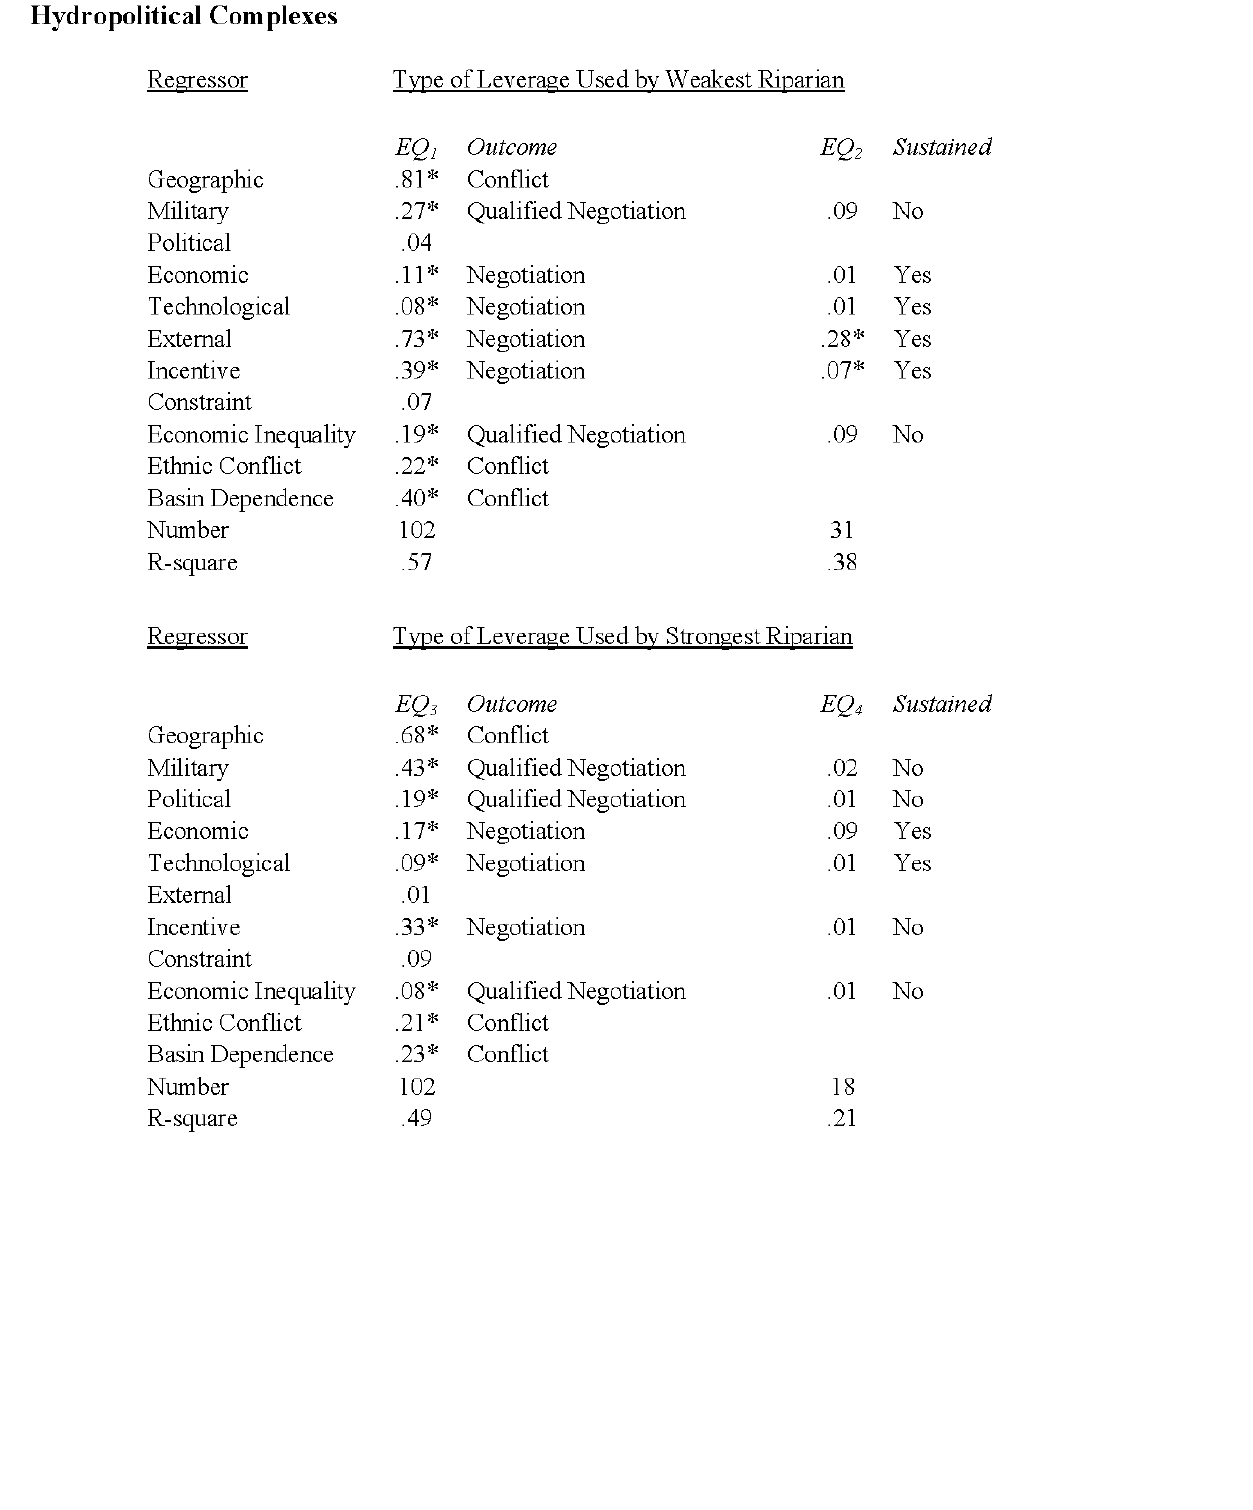
Table 1. The Effects of Specific Types of Leverage on Cooperation versus Conflict in Hydro political